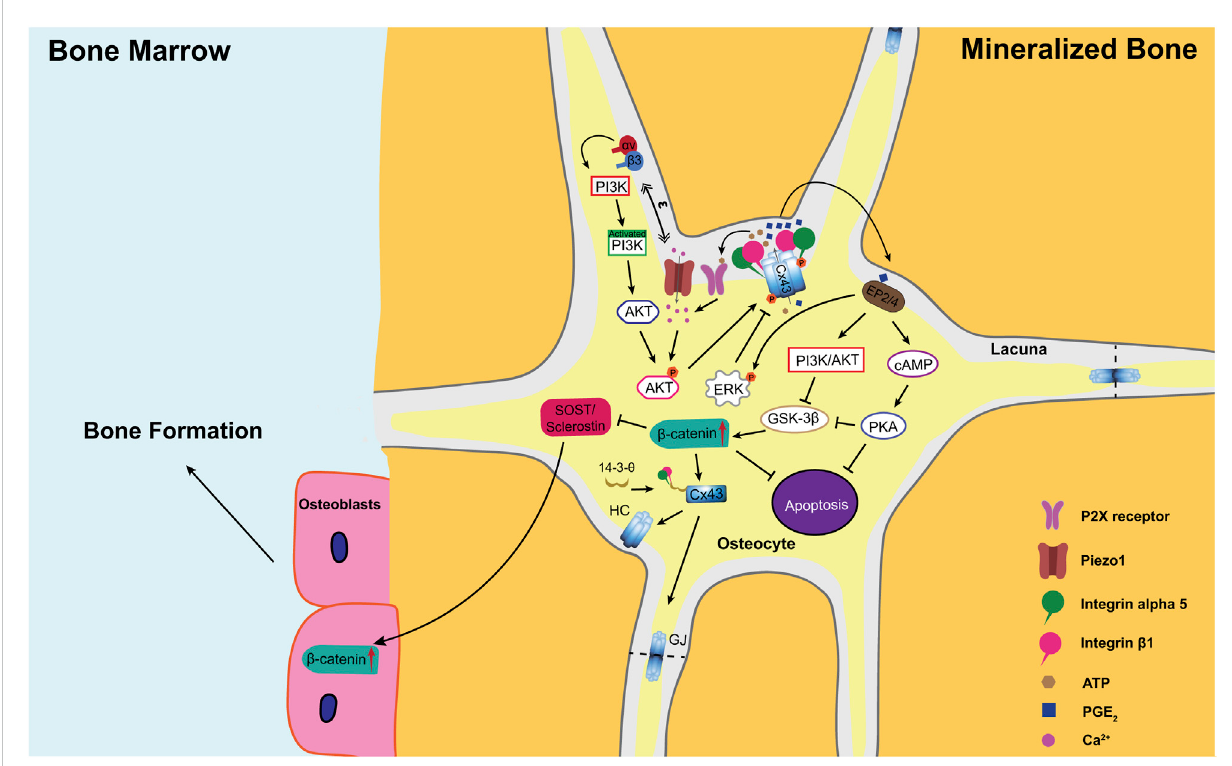
FIGURE 1 A model illustrating the role of PGE 2 released from Cx43 hemichannels under mechanical loading in the regulation of the anabolic response to mechanical stimulation in bone. Upon mechanical loading, osteocytic dendrites sense mechanical stimulation and transduce these signals through integrins α v β 3 to activate intracellular PI3K signaling (Wang et al., 2007; Riquelme et al., 2021). In addition, Ca 2+ in fl ux through Piezo1 also activates PI3K signaling (Zeng etal., 2022). Activated PI3K activates its downstream effector AKT through protein phosphorylation(Batra etal., 2014a). AKT,in turn, directly phosphorylates both Cx43 and integrin alpha 5 ( α 5) subunit (Batra et al., 2014a), which is required for the interaction between these two proteins (Batra et al., 2012). Additionally, the scaffolding molecule 14-3-3 θ facilitates the delivery of Cx43 and integrin a5 from the Golgi apparatus to the plasma membrane to form mechanosensitive Cx43 hemichannels (Batra et al., 2014b). Upon mechanical stimulation, integrin α 5 β 1 is activated and triggers the opening of hemichannels through the conformational change of the integrin (Batra et al., 2012). The opened Cx43 hemichannels mediate the export of intracellular PGE 2, whose synthesis is greatly increased by mechanical loading (Cherian et al., 2005; Siller-Jackson et al., 2008). Released PGE 2 acts in an autocrine/paracrinemannerthroughEP2/EP4receptorstoactivatebothcAMP/PKAandPI3k/Aktpathways(Xiaetal.,2010).Thesetwopathwaysprevent osteocyteapoptosisandpromotenucleartranslocationandaccumulationof β -catenininosteocytes(Kitaseetal.,2010),increasingCx43expressionand gap junction formation (Xia et al., 2010). In addition, increased β -catenin suppresses the sclerostin expression in osteocytes and enhances osteoblast activity and bone formation on endosteal surfaces (Zhao et al., 2022a; Zhao et al., 2022b). Moreover, high extracellular PGE 2 acts on EP2/4 receptors to activate ERK signaling, which directly phosphorylates Cx43 to promote the closure of the Cx43 hemichannels (Riquelme et al., 2015). GJ, gap junction; HC,